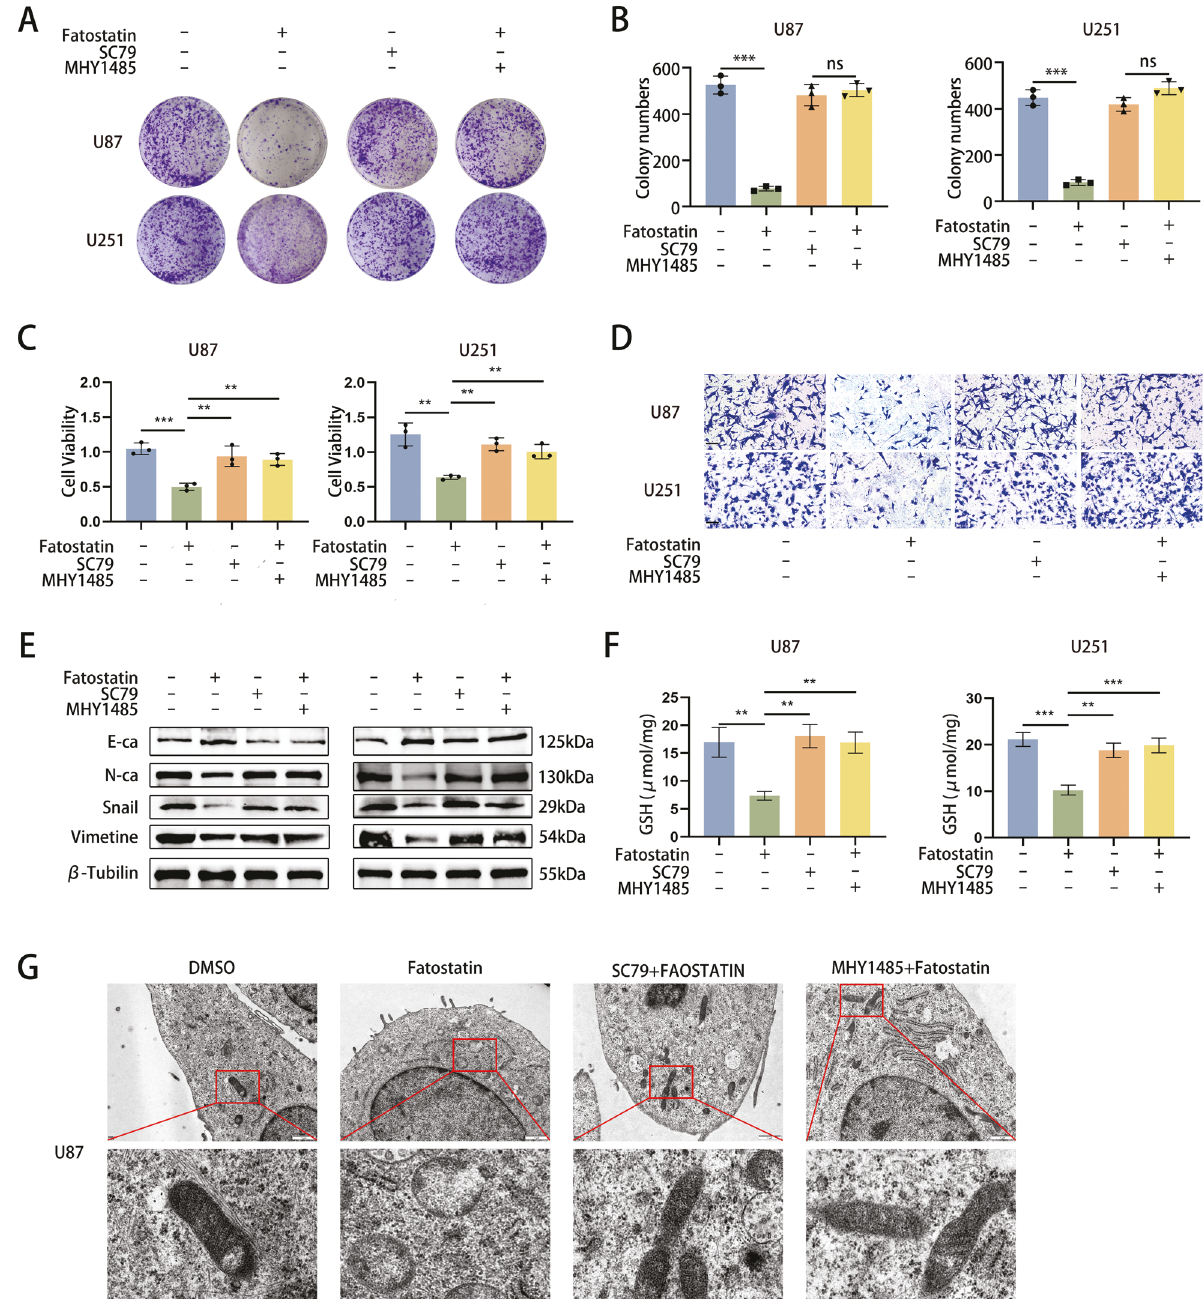
Fig. 6 Fatostatin inhibits proliferation and EMT and induces ferroptosis by suppressing the AKT/mTORC1 pathway. A , B The changes in colony numbers in U87 and U251 cells were reversed by SC79 or MHY1485. C CCK-8 assay results showed that the changes in U87 and U251 cells were reversed by SC79 or MHY1485. D Transwell assays revealed that the changes in the invasion of U87 and U251 cells were reversed by SC79 or MHY1485. E The changes in expression of E-ca, N-ca, Snail1, and Vimentin in U87 and U251 cells treated with fatostatin (20 μ M) for 24 h were reversed by SC79 or MHY1485. F The changes in the GSH levels in U87 and U251 cells were reversed by SC79 or MHY1485. G After DMSO, fatostatin, fatostatin + SC79, or fatostatin + MHY1485 treatment, U87 cells were prepared for transmission